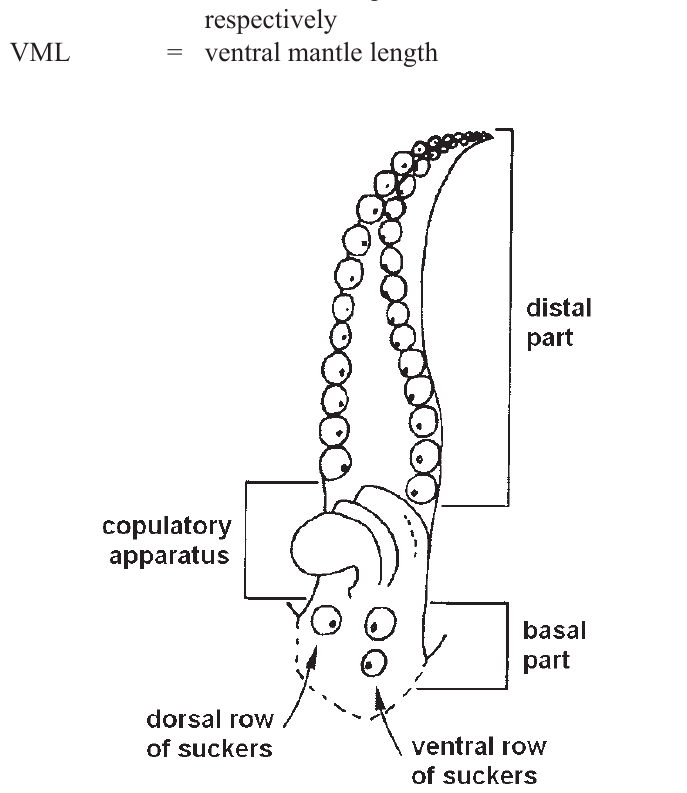
Fig. 1. Schematic rendering of the general hectocotylus (left arm I) in the Sepiola atlantica group sensu Naef (1923) (after Bello 1995,